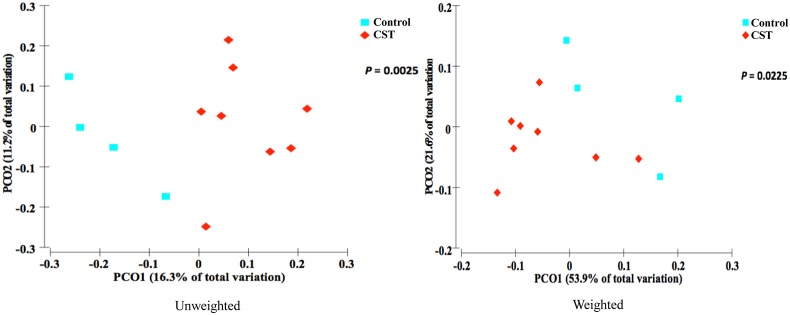
PCoA based on the unweighted and weighted UniFrac distance metric. Each colored point represents a fecal sample obtained from one mice and it is colored according to different treatment (CST or Control). P-values were calculated using PERMANOVA. Samples clustered according to treatment status of the mice (P < 0.05).